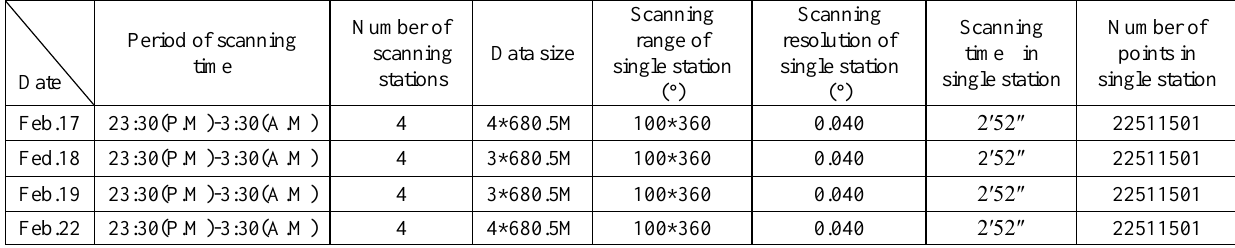
Table 6. The point cloud data information of the subway tunnel